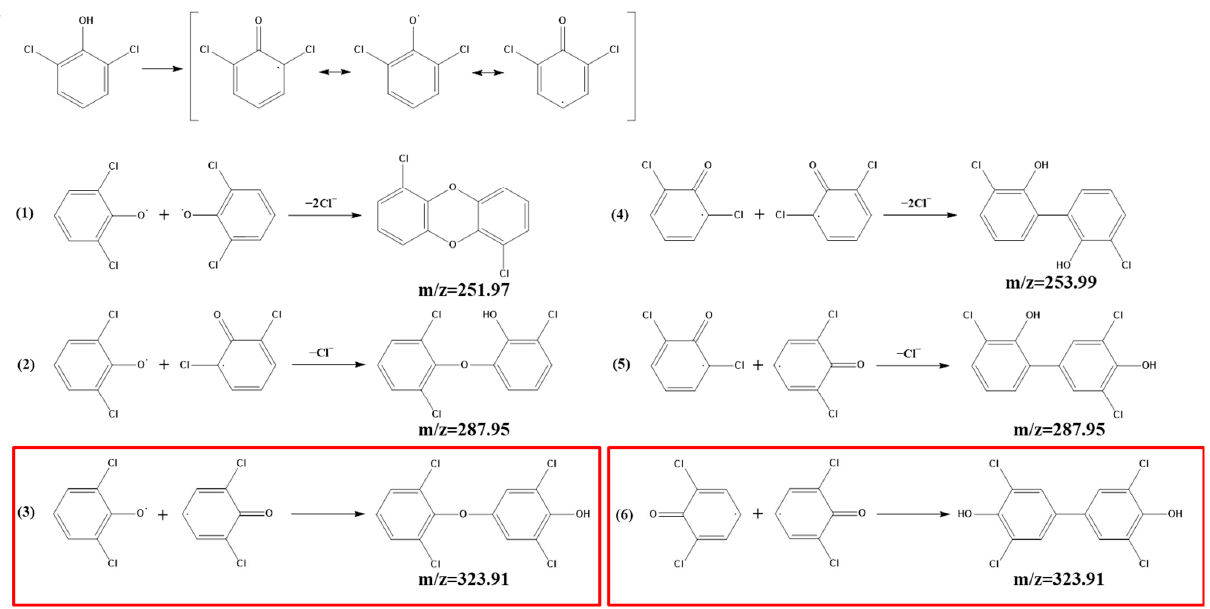
Figure 11. Free radicals generated by 2,6-DCP catalyzed by LAC-4 laccase ( A ) and the coupling reaction between the free radicals ( B ). 2,6-DCP was first oxidized by LAC-4 laccase, generating three chemically stable free radicals ( A ); then, six possible coupling reactions randomly occurred between the free radical monomers ( B ).